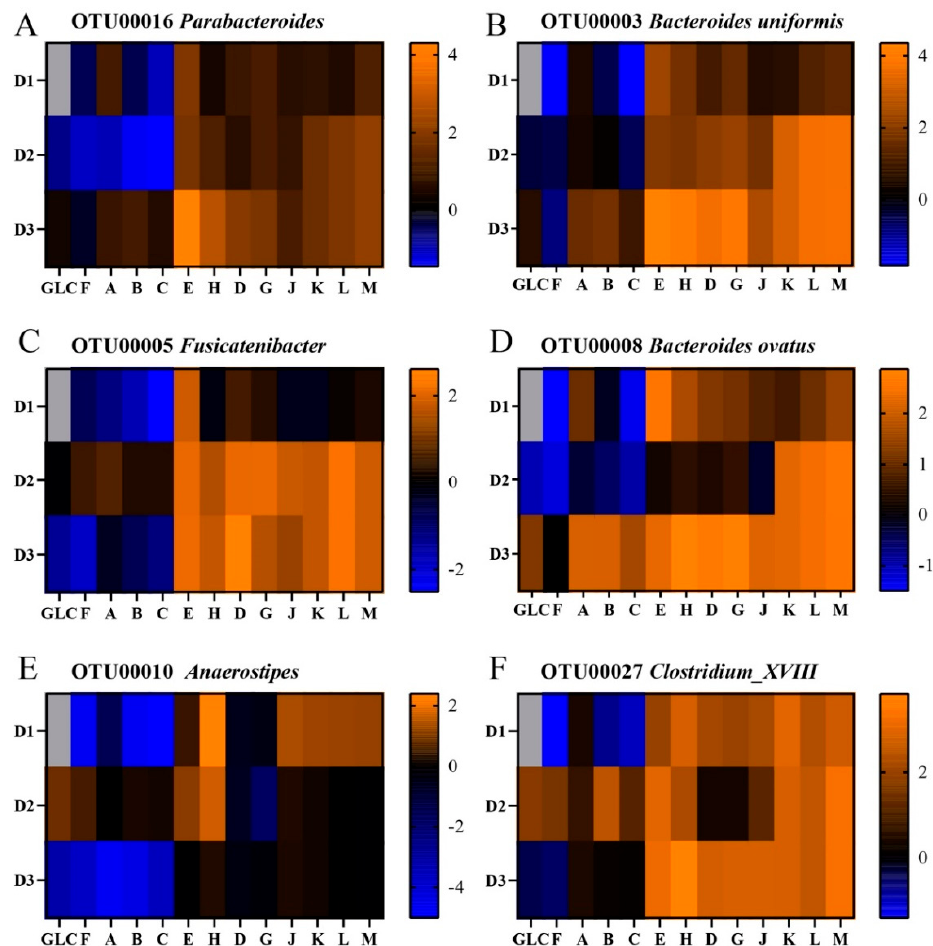
Figure 8. Log 2 -transformed fold change of OTU abundances after glucan fermentation (48 h post- inoculation relative abundances divided by fecal relative abundances). The fold changes of the six most responsive OTUs (OTU00016, ( A ); OTU00003, ( B ); OTU00005, ( C ); OTU00008, ( D ); OTU00010, ( E ); and OTU00027, ( F )) are depicted across all donors. Orange shades represent increases in abun- dance; blue shades represent decreases in abundance; black indicates no change with respect to the initial microbiota. OTUs not detected within an individual’s inoculum are